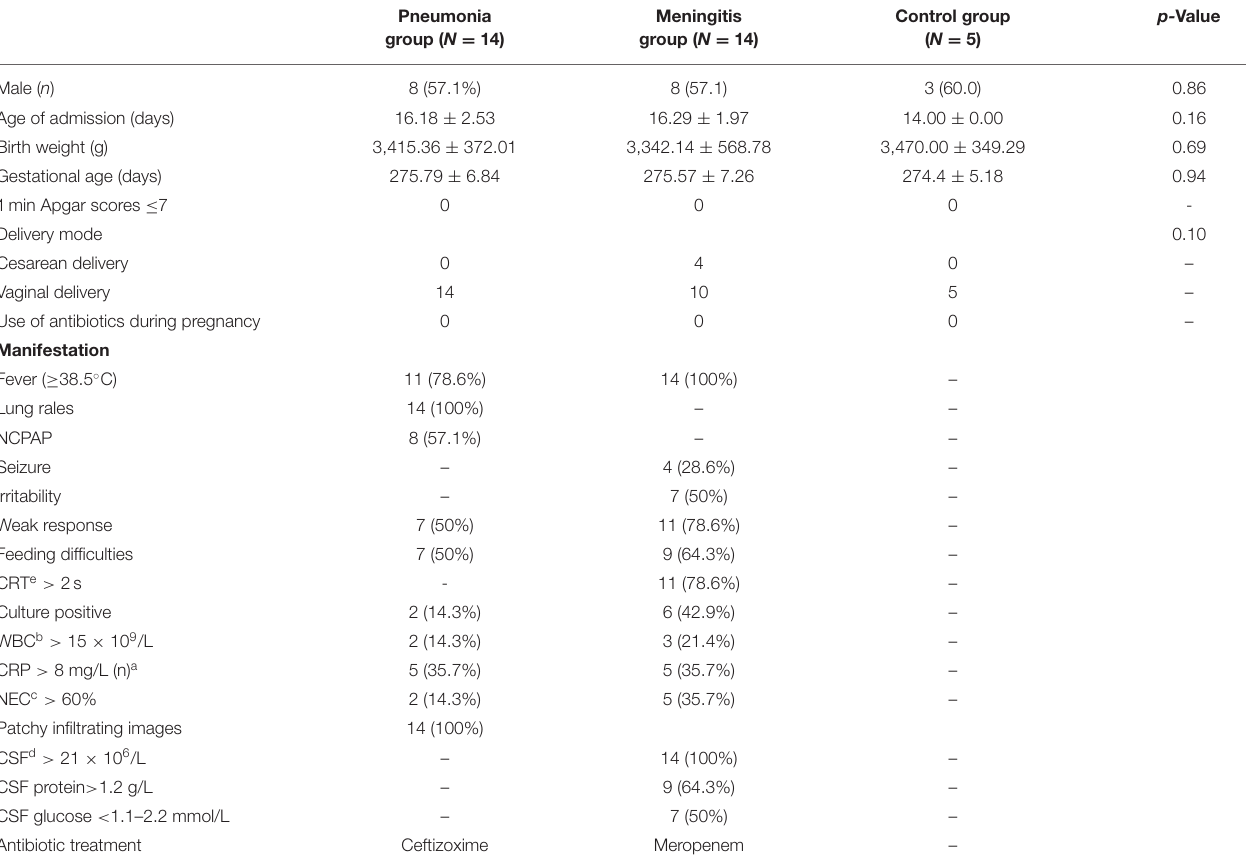
TABLE 1 | General information and antibiotic treatment of